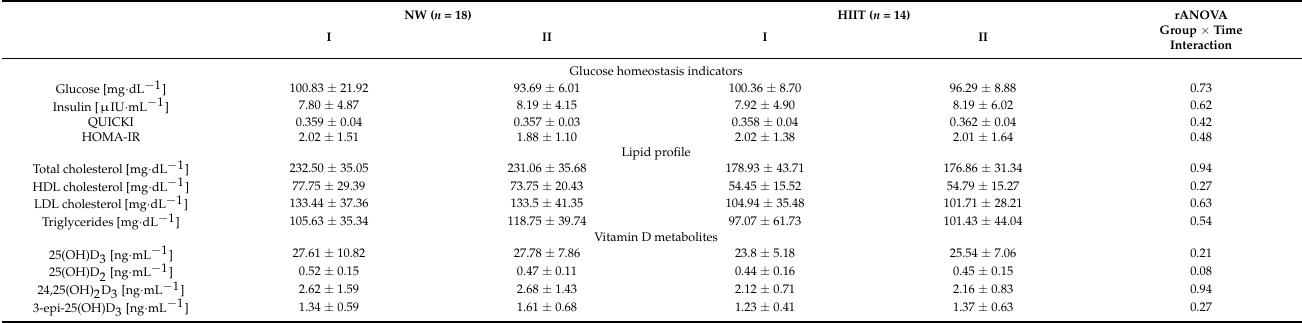
Table 2. Glucose, lipids and metabolite of vitamin D parameters before and after NW and HIIT trainings